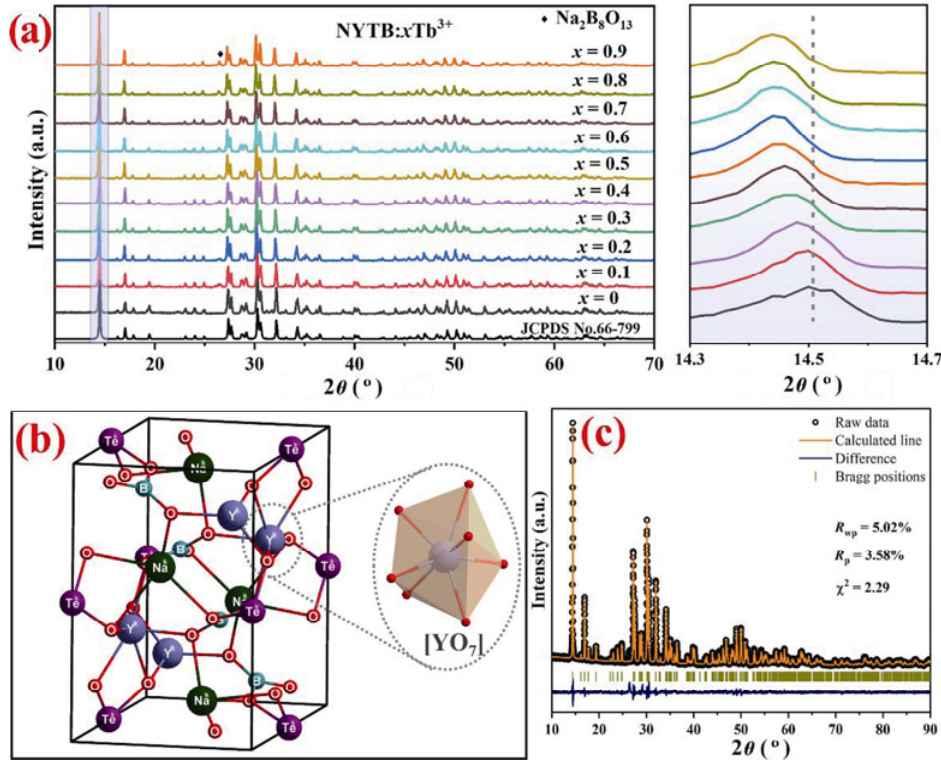
Fig. 1 (a) XRD patterns of NYTB: x Tb 3+ ( x = 0  90 mol%) and magnified view of dominant diffraction peak. (b) Crystal structure of NYTB and coordination of Y 3+ . (c) Rietveld refinement pattern for NYTB:70%Tb 3+